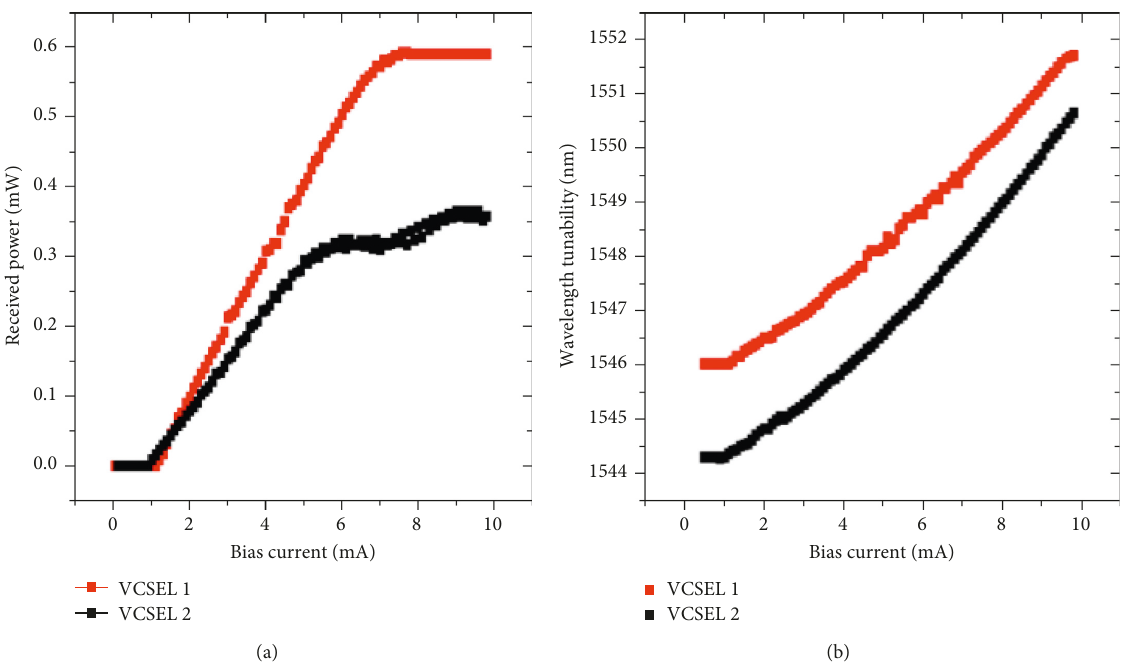
00.0 Figure 3: (a) Output power and (b) wavelength tunability of a VCSEL as a function of bias current